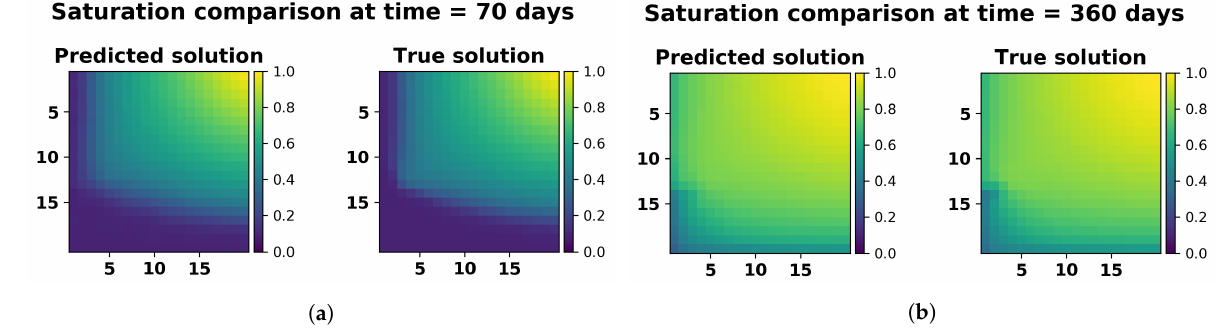
Figure 8. Saturation solution comparison at ( a ) Time = 70 days and ( b ) Time = 360 days.